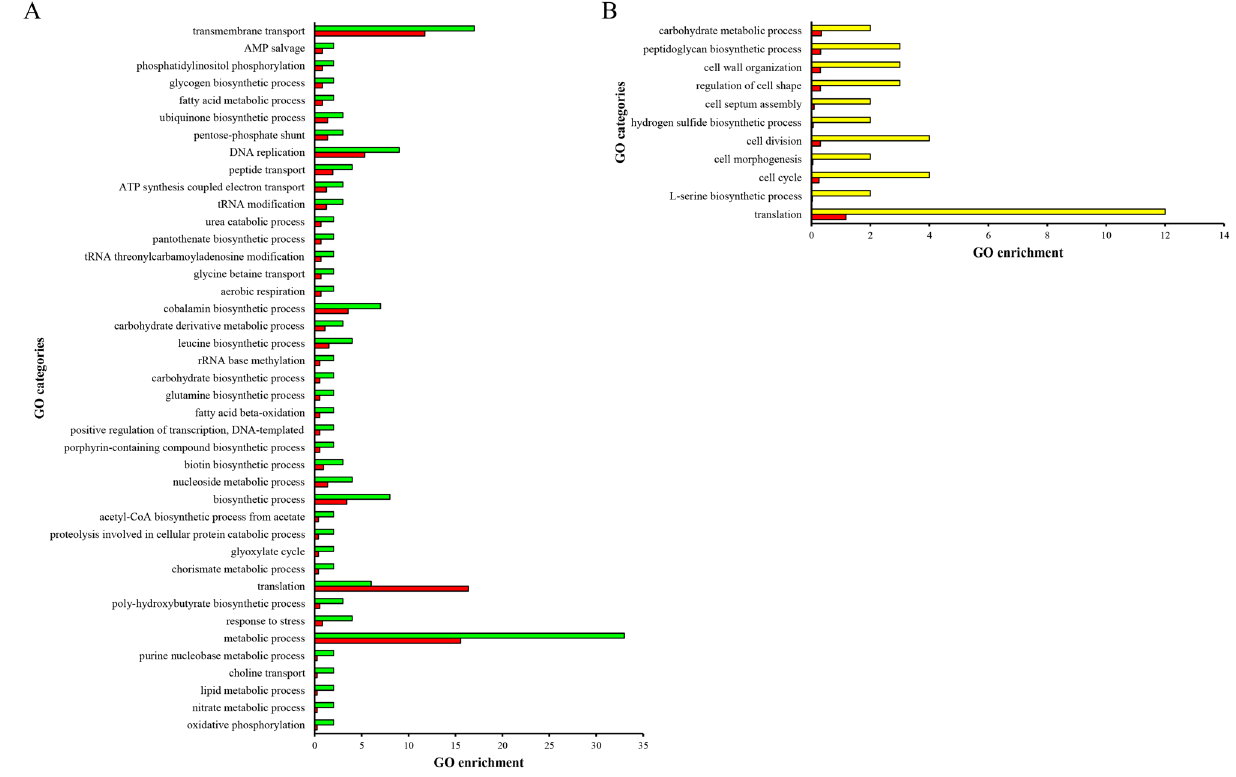
Figure 2. Significant changes in Gene Ontology (GO) groups affected by pH in P. denitrifcans PD1222 in the comparative study pH 7.2/pH 6.5. Only changes in GO groups with a p- value < 0.05 are shown. The third level of biological function GO was used for proteins with significant differential expression and a hypergeometric test ([E(GOi)]), where [E(GOi)] = sample size/genome size × GOi, was evaluated 21 . In this analysis the P. denitrificans PD1222 whole genome was used as reference (red bars) and GO groups of significantly over-represented proteins at pH 7.2 are shown in green bars ( A ), whereas down-represented proteins are shown in yellow bars ( B